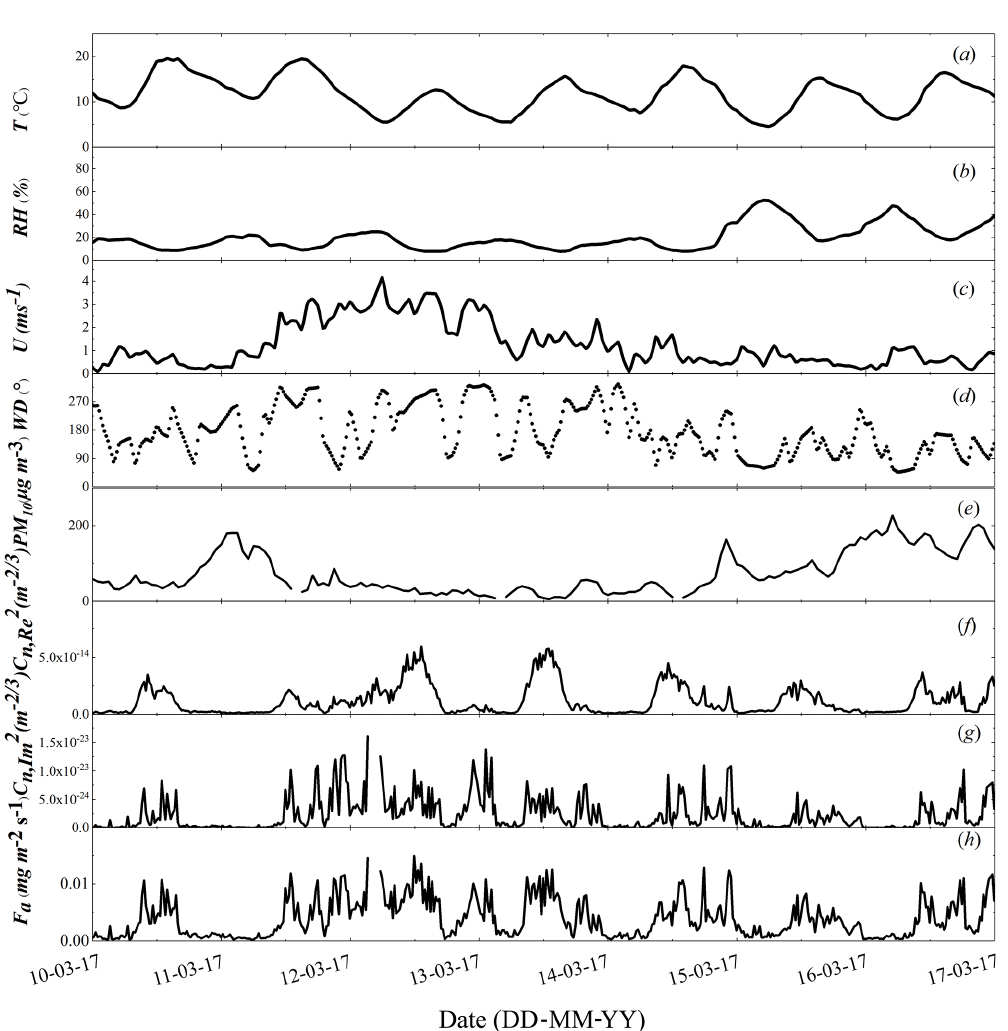
Figure 3. Temporal variations in (a) air temperature, (b) RH, (c) wind speed, (d) wind direction, (e) PM 10 , (f) real part of the AERISP, (g) imaginary part of the AERISP, and (h) aerosol mass flux in the Beijing area from 10 to 17 March